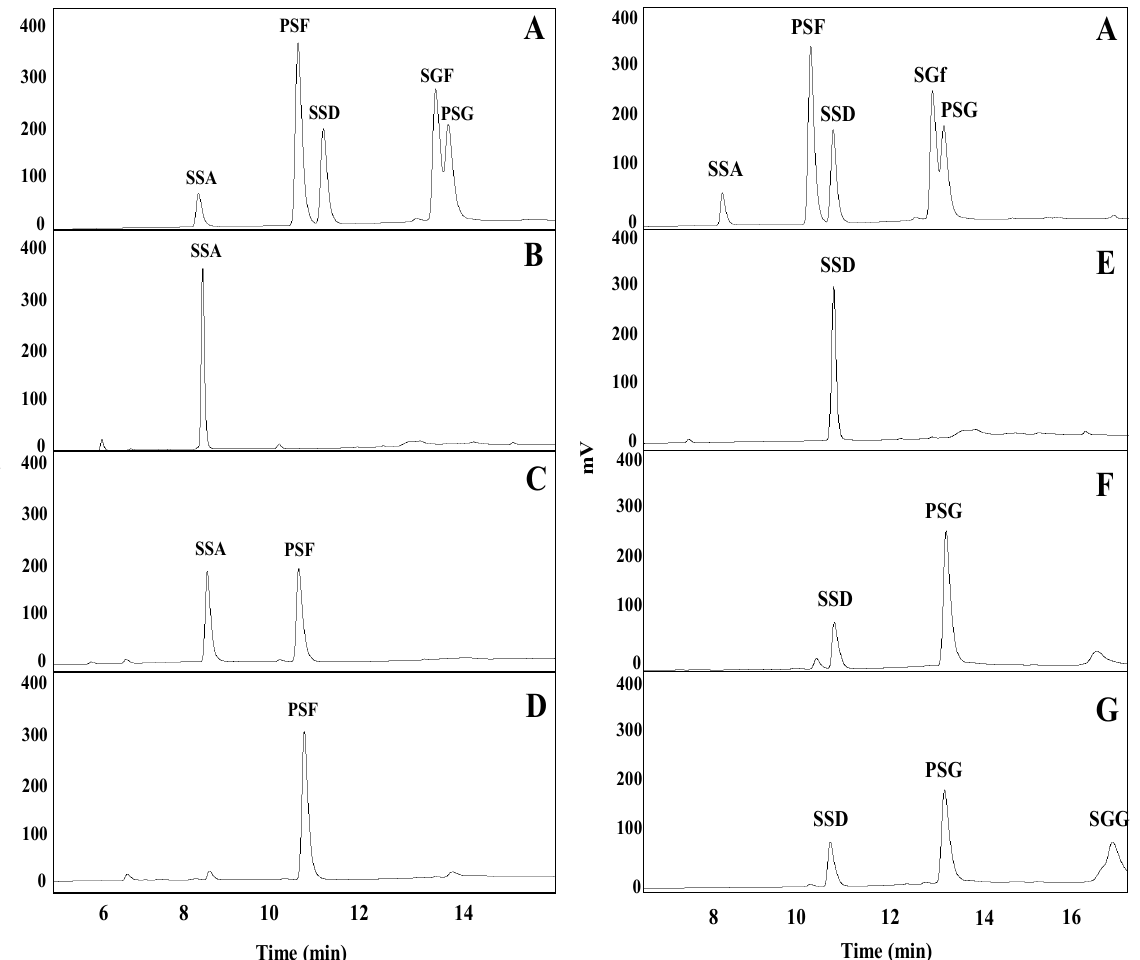
Figure 4. HPLC results of the biotransformation saikosaponin A and saikosaponin D by BglPm and BglLk, respectively ( A ) saikosaponin standard; ( B ) substrate saikosaponin A; ( C ) the reaction after two-hours treatment with BglPm; ( D ) the reaction after eight-hours treatment with BglPm; ( E ) substrate saikosaponin D; ( F ) the reaction after two-hours treatment with BglLk; ( G ) the reaction six-hours treatment with BglLk.